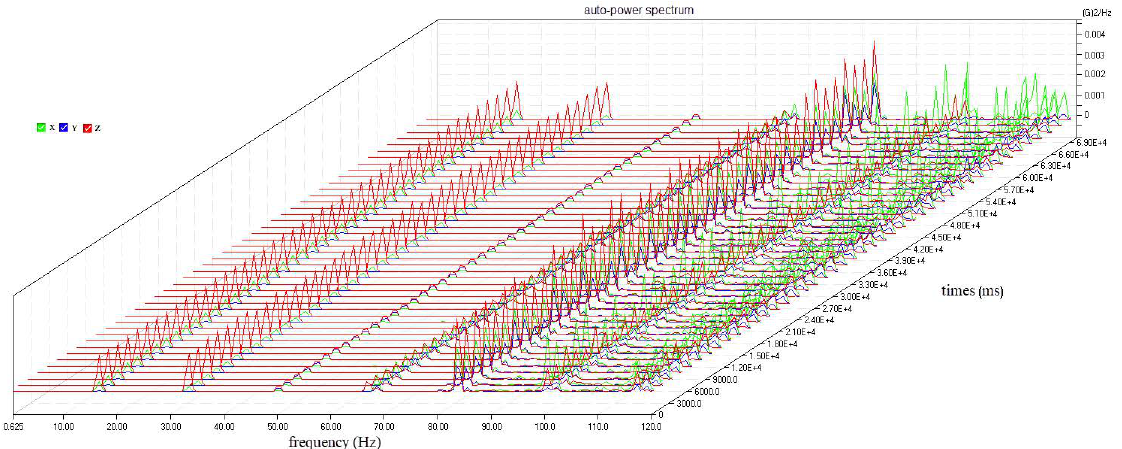
Figure 10. Waterfall diagram of the auto-power spectrum for an unbalanced trailing-edge